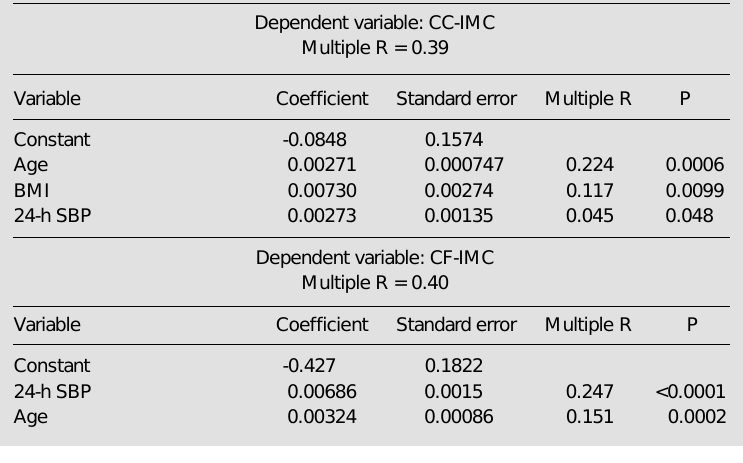
Table 3 - Results of forward stepwise multiple regression of factors influencing common carotid (CC)- and common femural (CF)-intima-media complex (IMC) in normotensive controls (N = 63). BMI, Body mass index; SBP, systolic blood pressure.